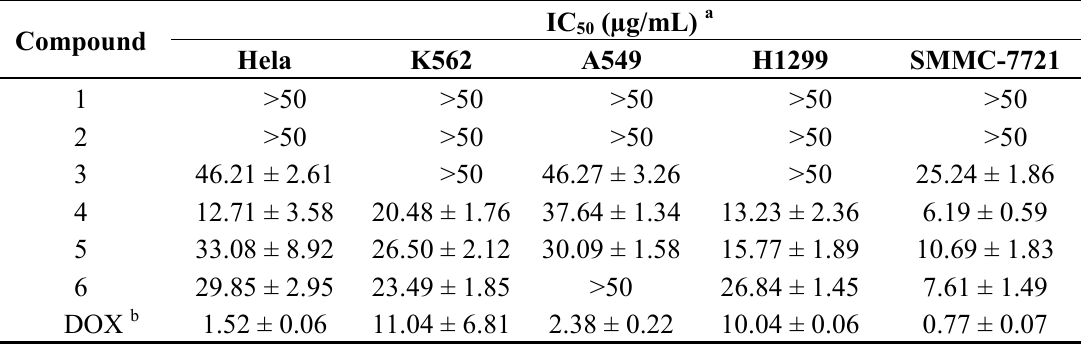
DOX b 1.52 ± 0.06 11.04 ± 6.81 2.38 ± 0.22 10.04 ± 0.06 0.77 ±